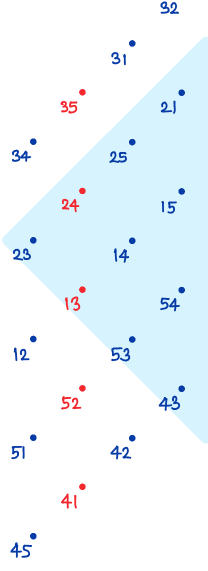
Figure 7 . Fundamental domain F 13 in n = 5